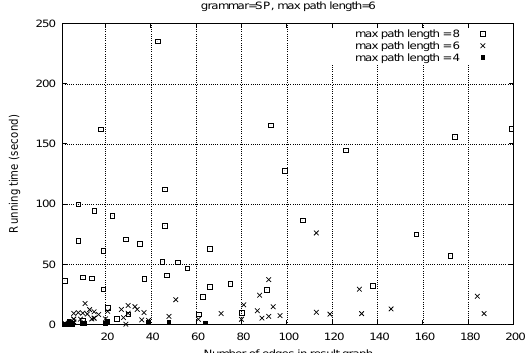
Figure 5: Running times with real